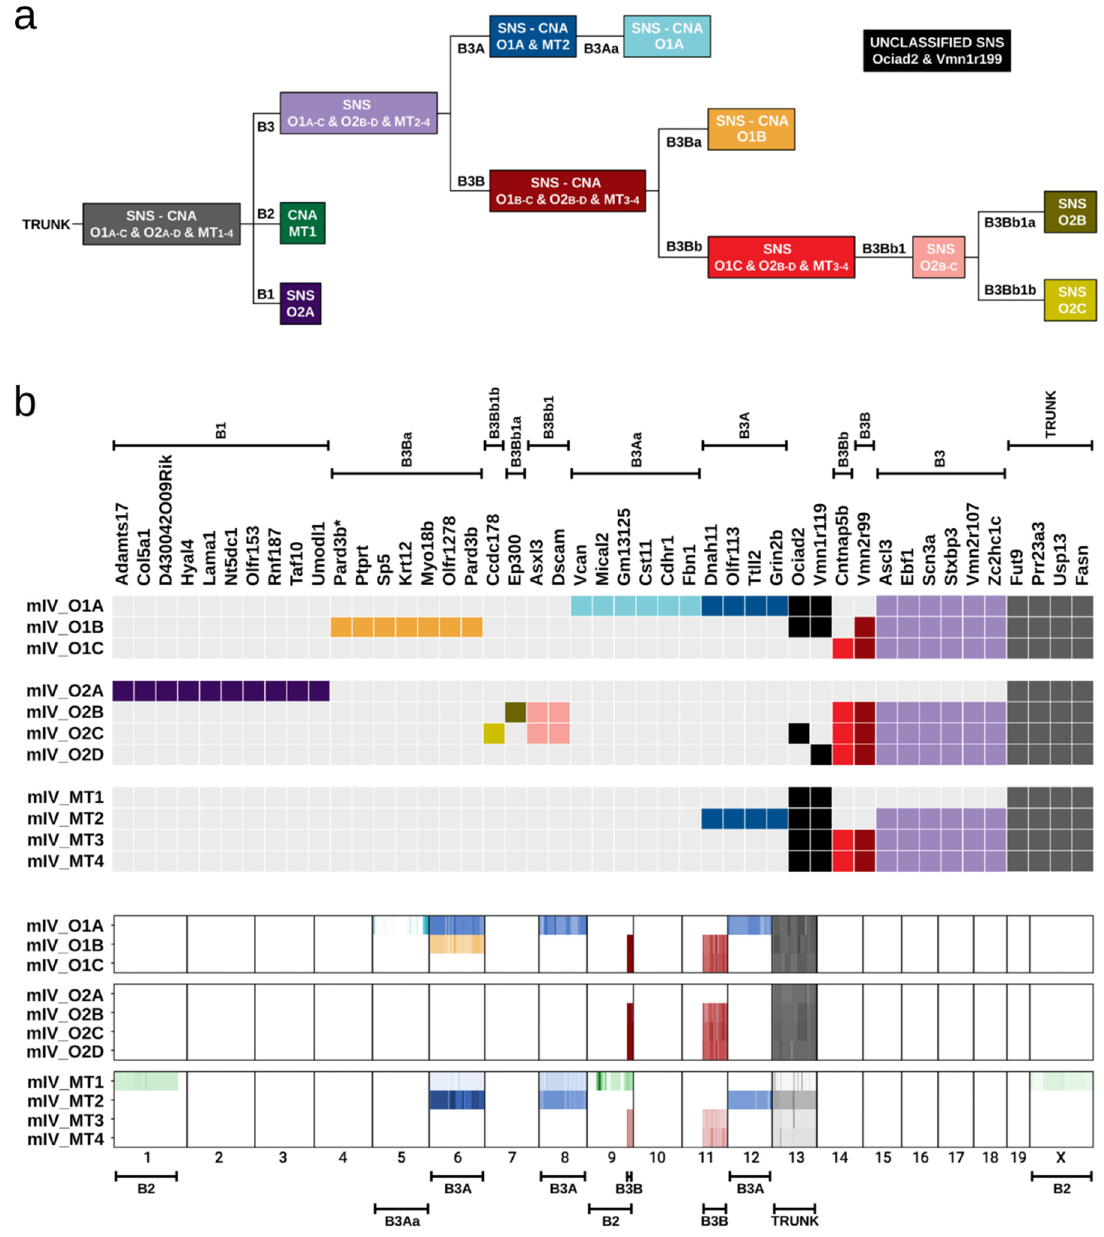
Figure 6. Phylogenetic analysis of tumour progression in mouse IV. ( a ) Phylogenetic tree illustrating the temporal order of acquisition of the SNSs and CNAs. The branches (B) of the tree are numbered. ( b ) Colour-coding of the SNSs and CNAs according to the phylogenetic analysis. The SNSs and CNAs belonging to the same branch of the phylogenetic tree have the same colour.